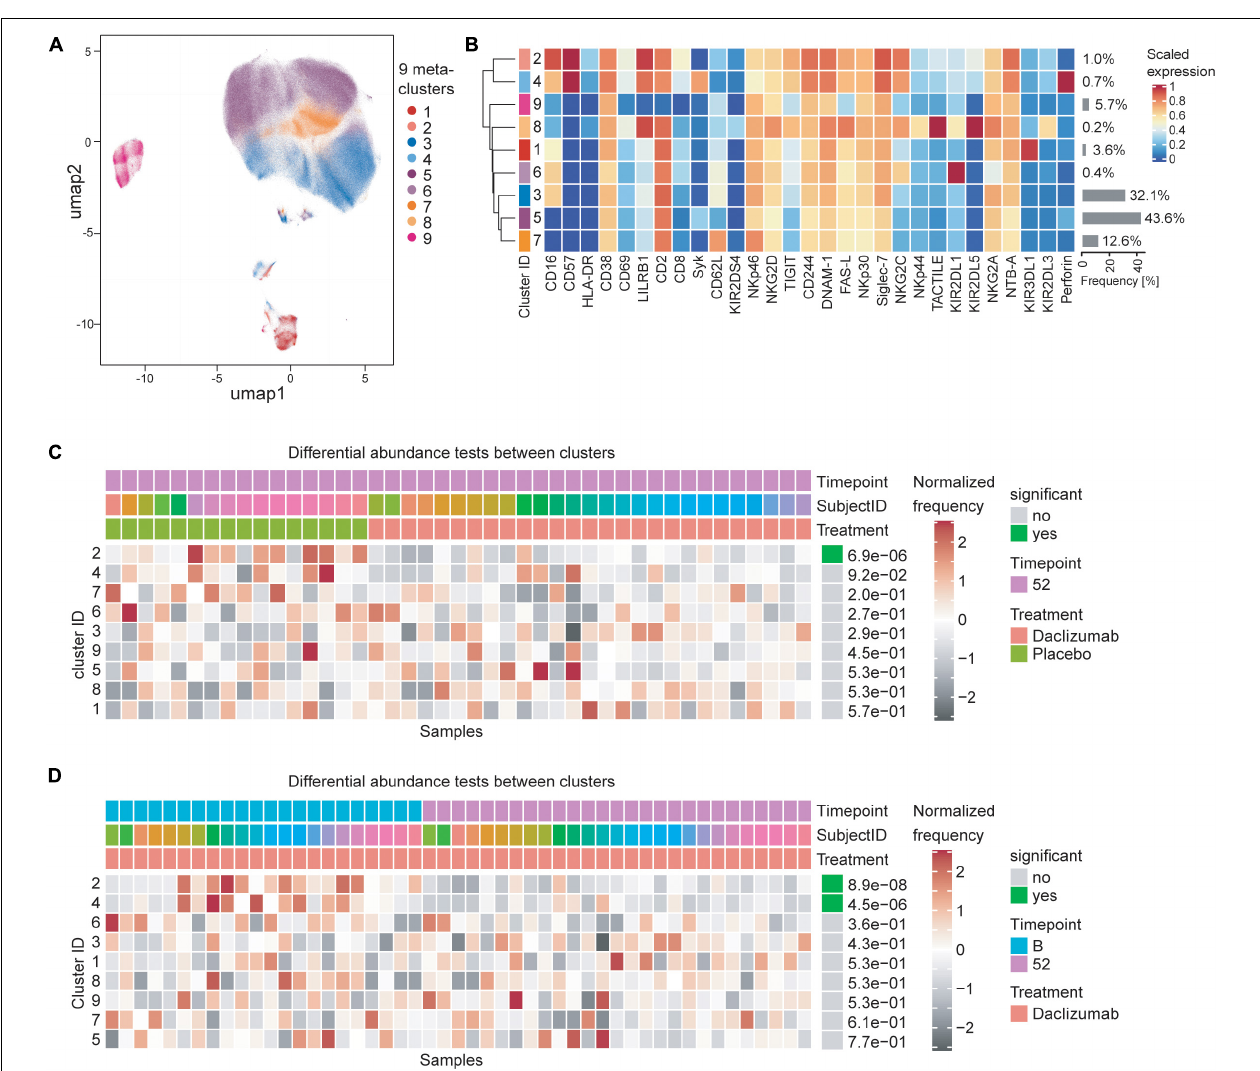
FIGURE 3 | Daclizumab beta treatment does not alter a specific subset of CD56 bright NK cells. (A) The CATALYST package was used to perform clustering on all CD56 bright NK cells from both placebo and daclizumab beta treated groups at all time points. Using the delta area plot provided by the clustering analysis, 9 metaclusters were retained. The metaclusters are displayed in the UMAP space, and colored by metacluster. (B) The heatmap shows the cluster IDs (leftmost column) hierarchically ordered by similarity (dendrogram calculated using Euclidean distance as a metric and average as a linkage). Markers are labeled at the bottom of the heatmap. The marker expressions are scaled to values between 0 and 1. Along the right side of the heatmap, the frequency of each cluster among the total CD56 bright NK population is shown in gray bars, with the frequency printed next to it. (C) Differential abundance test between clusters at 52 weeks of treatment comparing placebo and daclizumab beta treatment. Across the top, Timepoint, Subject ID, and Treatment are shown for each sample (columns). The heatmap represents the proportion of each metacluster in each sample, with gray showing under-representation and red showing over-representation. The proportions are first scaled with arcsine-square-root transformation and then z-score normalized in each cluster. The cluster ID is labeled along the left side of the heatmap, ordered by significance, which is shown along the right side of the heatmap. The differential abundance test reports adjusted p -values (FDR). (D) Differential abundance test between clusters within the daclizumab beta treated group, comparing baseline and 52 weeks of treatment. Across the top, Timepoint, Subject ID, and Treatment are shown for each sample (columns). The cluster ID is labeled along the left side of the heatmap, ordered by significance, which is shown along the right side of the heatmap. The differential abundance test reports adjusted p -values